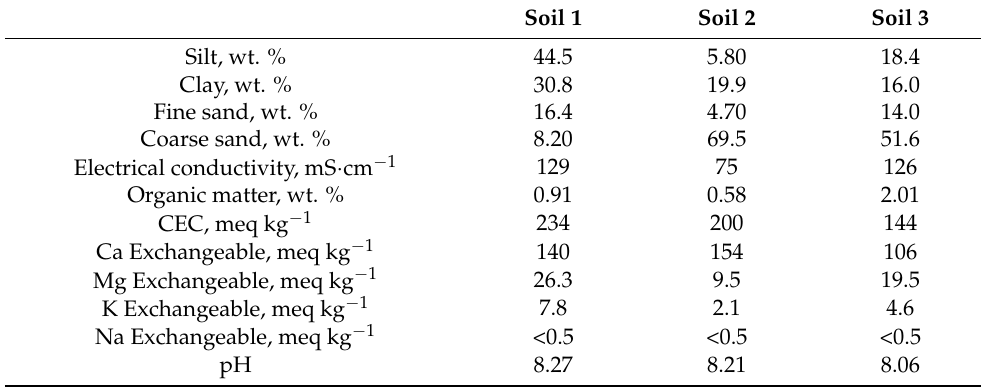
Table 3. Physical and chemical properties of the studied Mediterranean